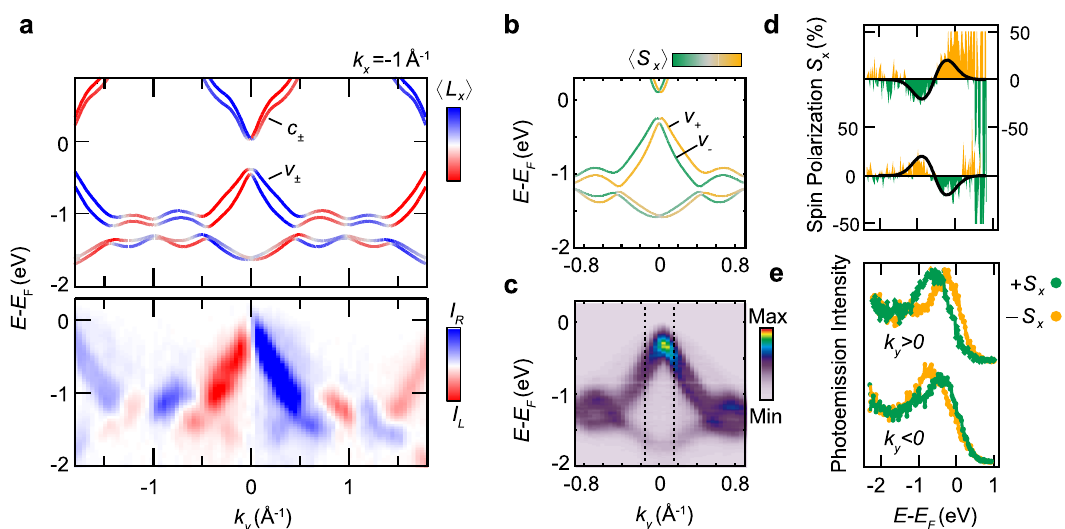
Fig. 2 Orbital and spin-angular momentum of bulk electronic states in TaAs. a Calculated bulk band dispersion of TaAs projected on the component L x of the orbital-angular momentum (OAM). The cut along k y is taken at k z ¼ (cid:2) 0 : 59 2 π c and k x = − 1 Å − 1 . The spin – orbit split valence band v ± and conduction band c ± are indicated. The calculation is compared to a corresponding CD-ARPES data set in the bottom panel, obtained at h ν = 590 eV (see indication in Fig. 1f). The red/blue color code represents the circular dichroism (CD) measured with circularly polarized X-rays incident in the xz -plane (cf. Fig. 1b). b Calculated band dispersion projected on the component S x of the spin-angular momentum (SAM), showing opposite S x for v ± . c ARPES data set along k y taken at h ν = 590 eV and k x = − 1 Å − 1 . Dashed lines indicate the k y positions of the spin-resolved energy distribution curves (EDC) in e . d , e , Spin-resolved EDC and measured spin polarization at ± k y , as indicated in c . The spin quantization axis is along x . Data sets at + k y ( − k y ) were measured with left (right) circularly polarized light (see Supplementary Note 2 for